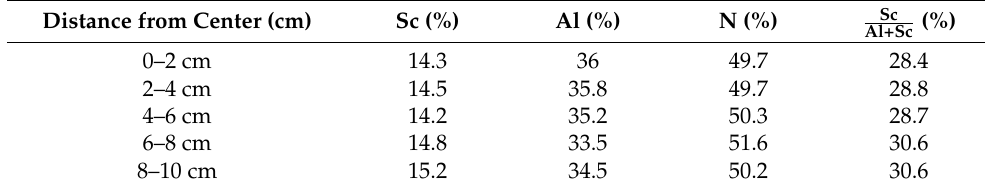
Table 3. RBS atomic composition at different wafer spots.